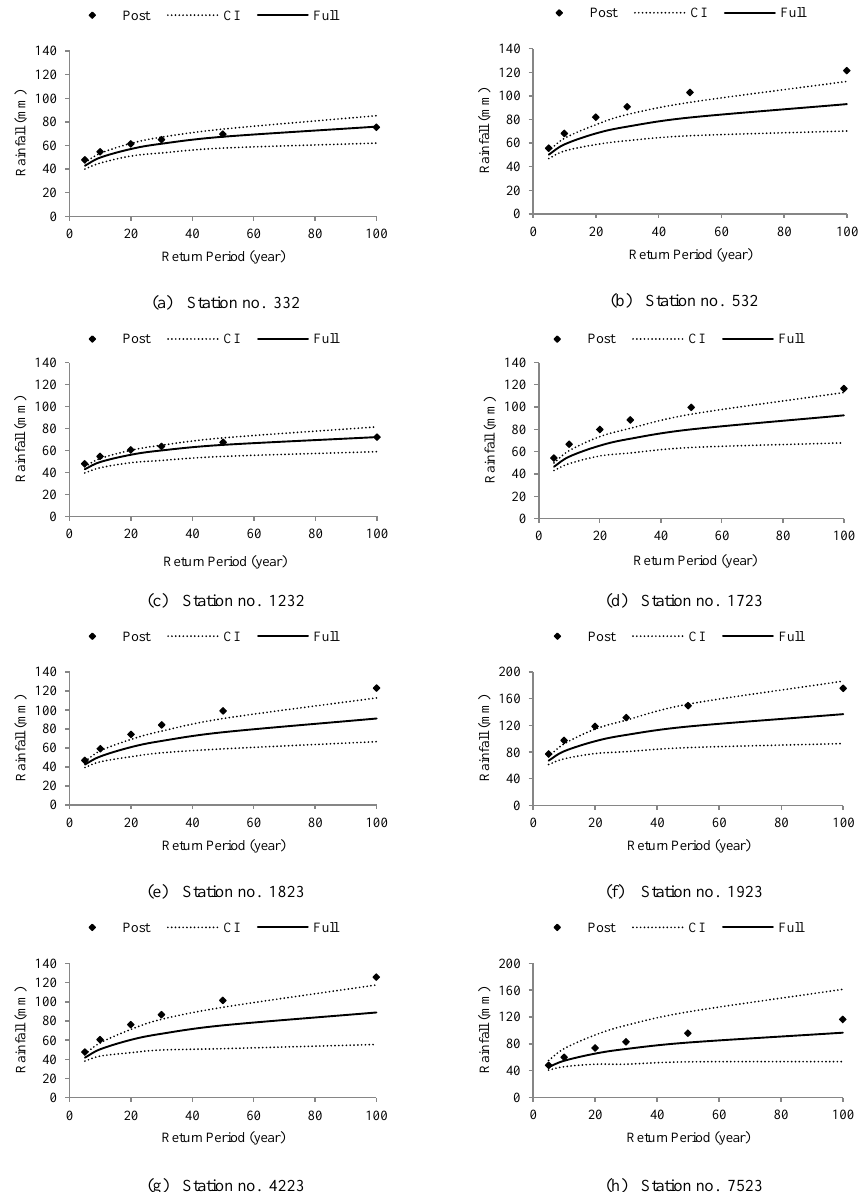
Figure 3. Depth-frequency relationships using the full record (Full) with confidence intervals (CI) and for the post step-change data only